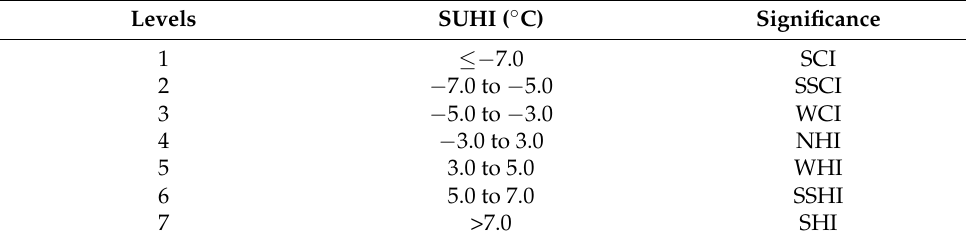
Table 1. Levels and implications of different SUHI values.